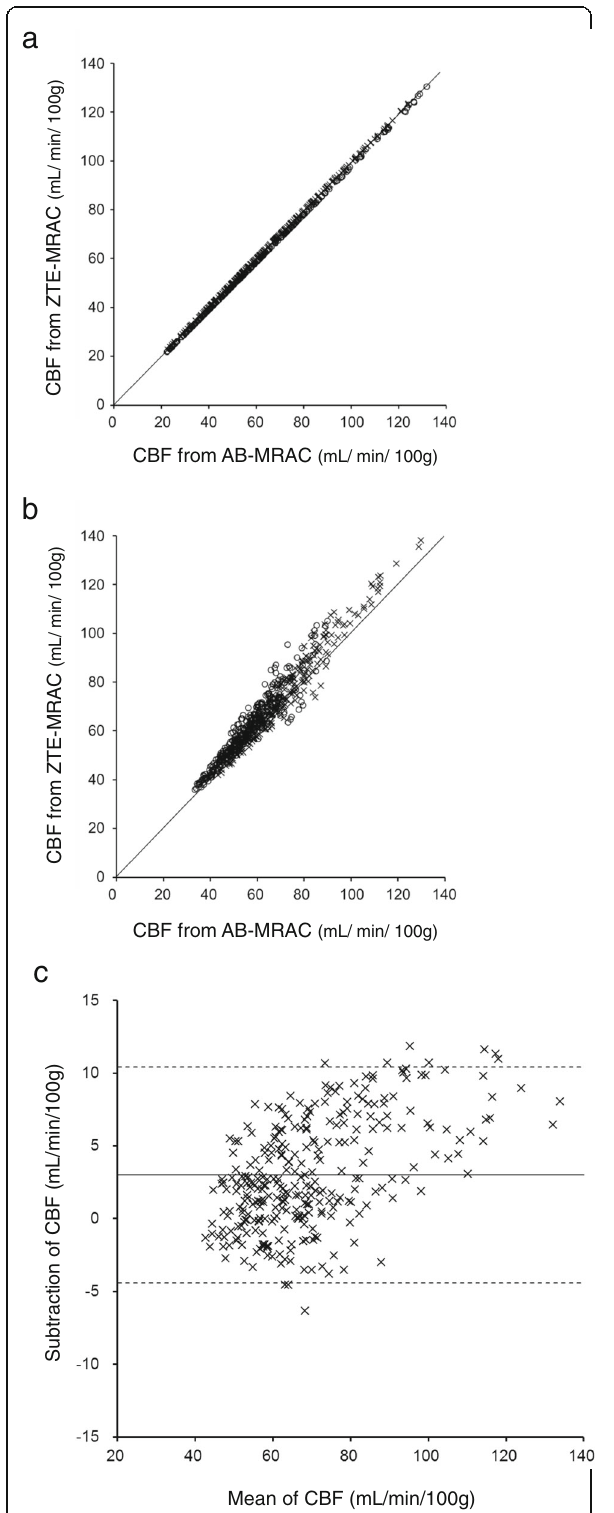
Fig. 5 Two representative regression analyses for regional CBF obtained from 310 ROIs for all brain regions (see Table 1). The first case ( a ) showed excellent correlation at baseline ( ○ : y = 0.99 x + 0.48, R 2 = 1.0) as well as after acetazolamide administration (×: y = 0.99 x + 0.13, R 2 = 1.0). Several cases showed slightly greater variance, as shown in panel ( b ), although the correlation coefficient was excellent (baseline ( ○ ): y = 1.1 x + 4.5, R 2 = 0.96; acetazolamide (×): y = 1.1 x + 1.3, R 2 = 0.90). Graph c shows the Bland-Altman plot for the second case which had no significant bias, although the AB-MRAC CBF image tended to show greater values in the higher range of the CBF mean (mean difference 3.0 ± 3.8; range − 4.4 – 10.4 mL/min/100